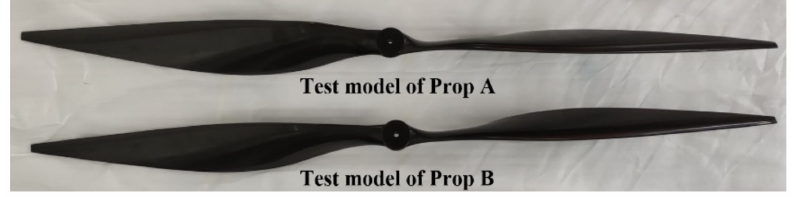
Figure 24. The test models.